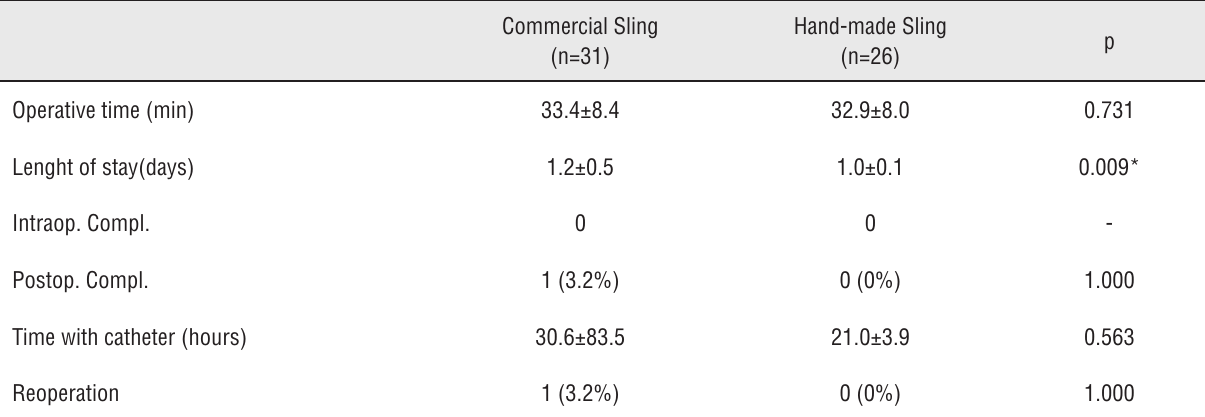
Table 3 – Surgical data. Data expressed in (mean±standard deviation) or n (%).